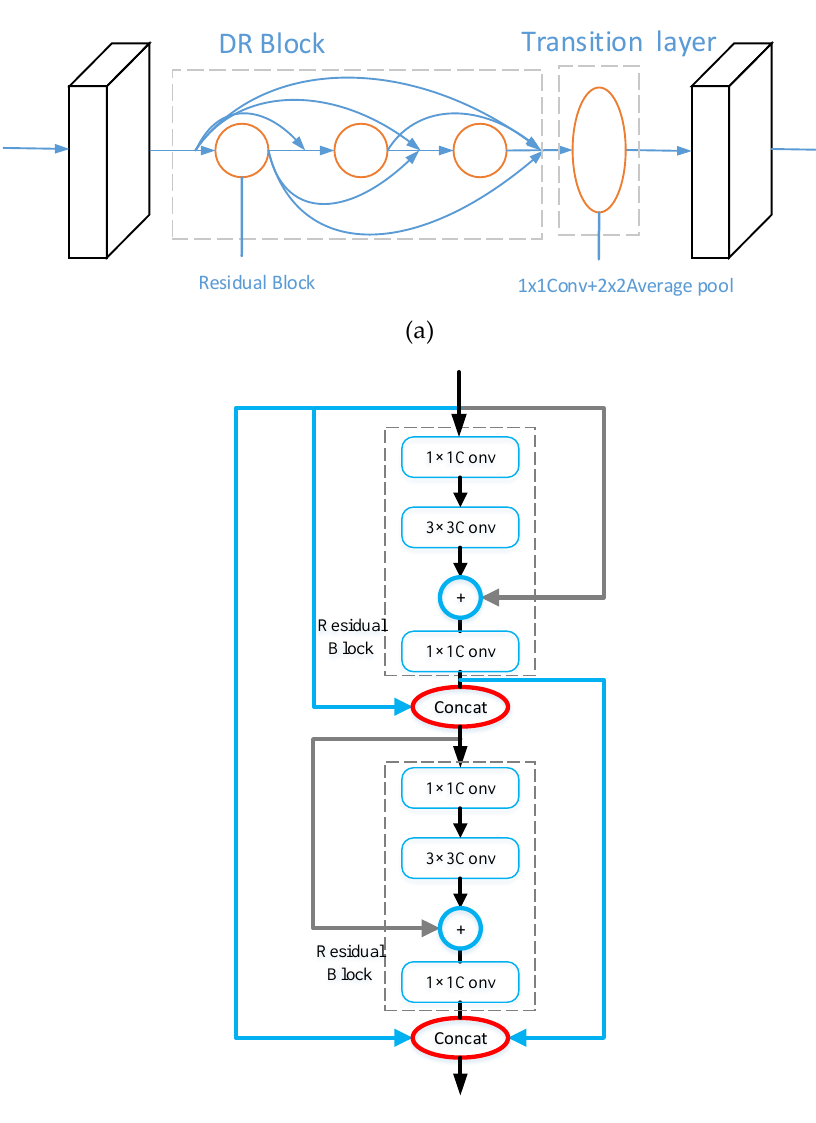
Figure 2. Schematic of a Dense Residual Network (DRNet).